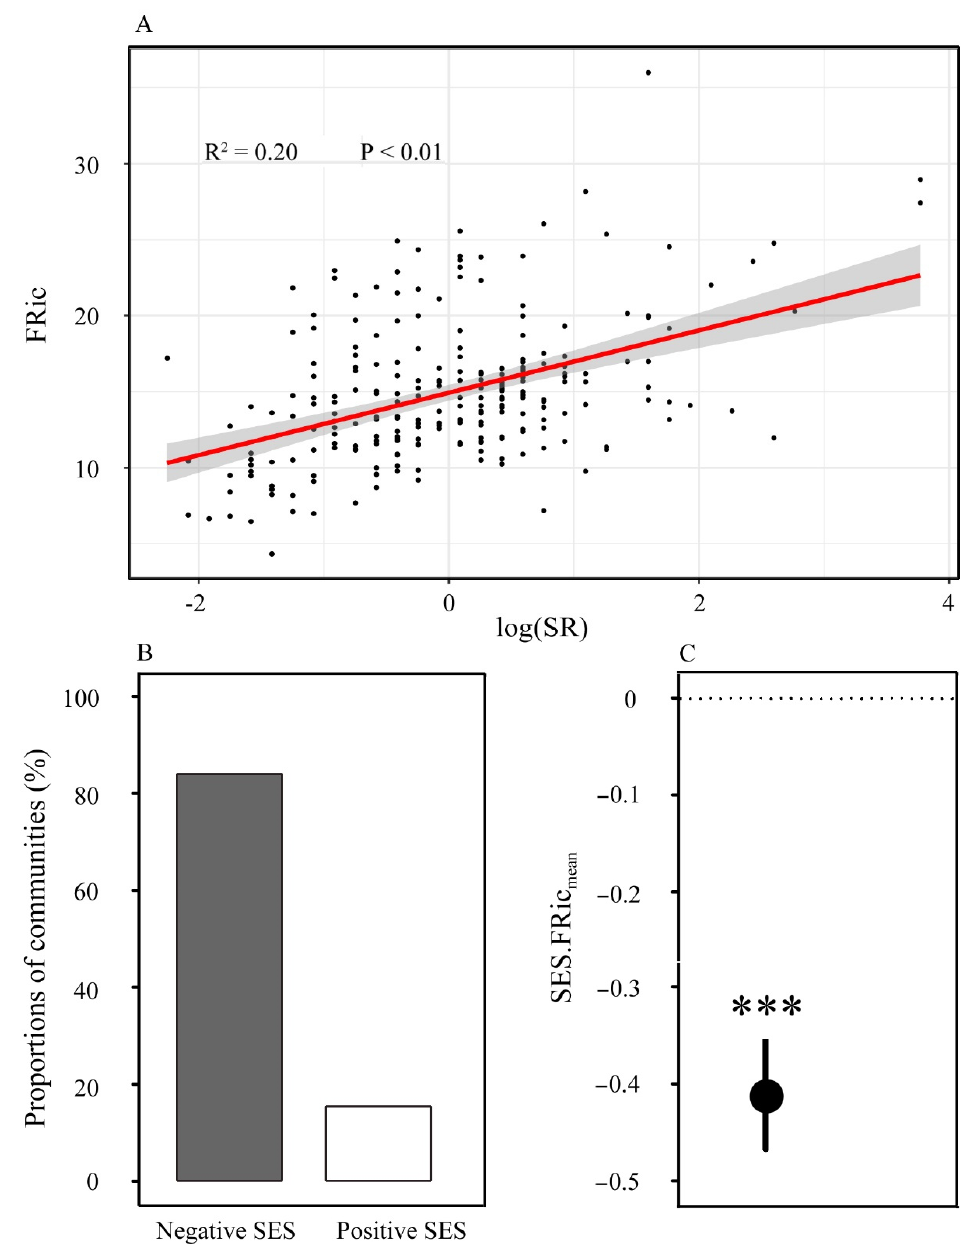
Figure 3. ( A ) Correlations between functional diversity (FRic) and (log-transformed) species richness [log(SR)]. ( B ) The relative prevalence of negative SES.FRic versus positive SES.FRic in forest communities, evaluated based on standardized effect size of the FRic. ( C ) Mean (mean ±95% confidence interval) of standardized effect size of the FRic across all communities (n = 250). ***, p < 0.001.